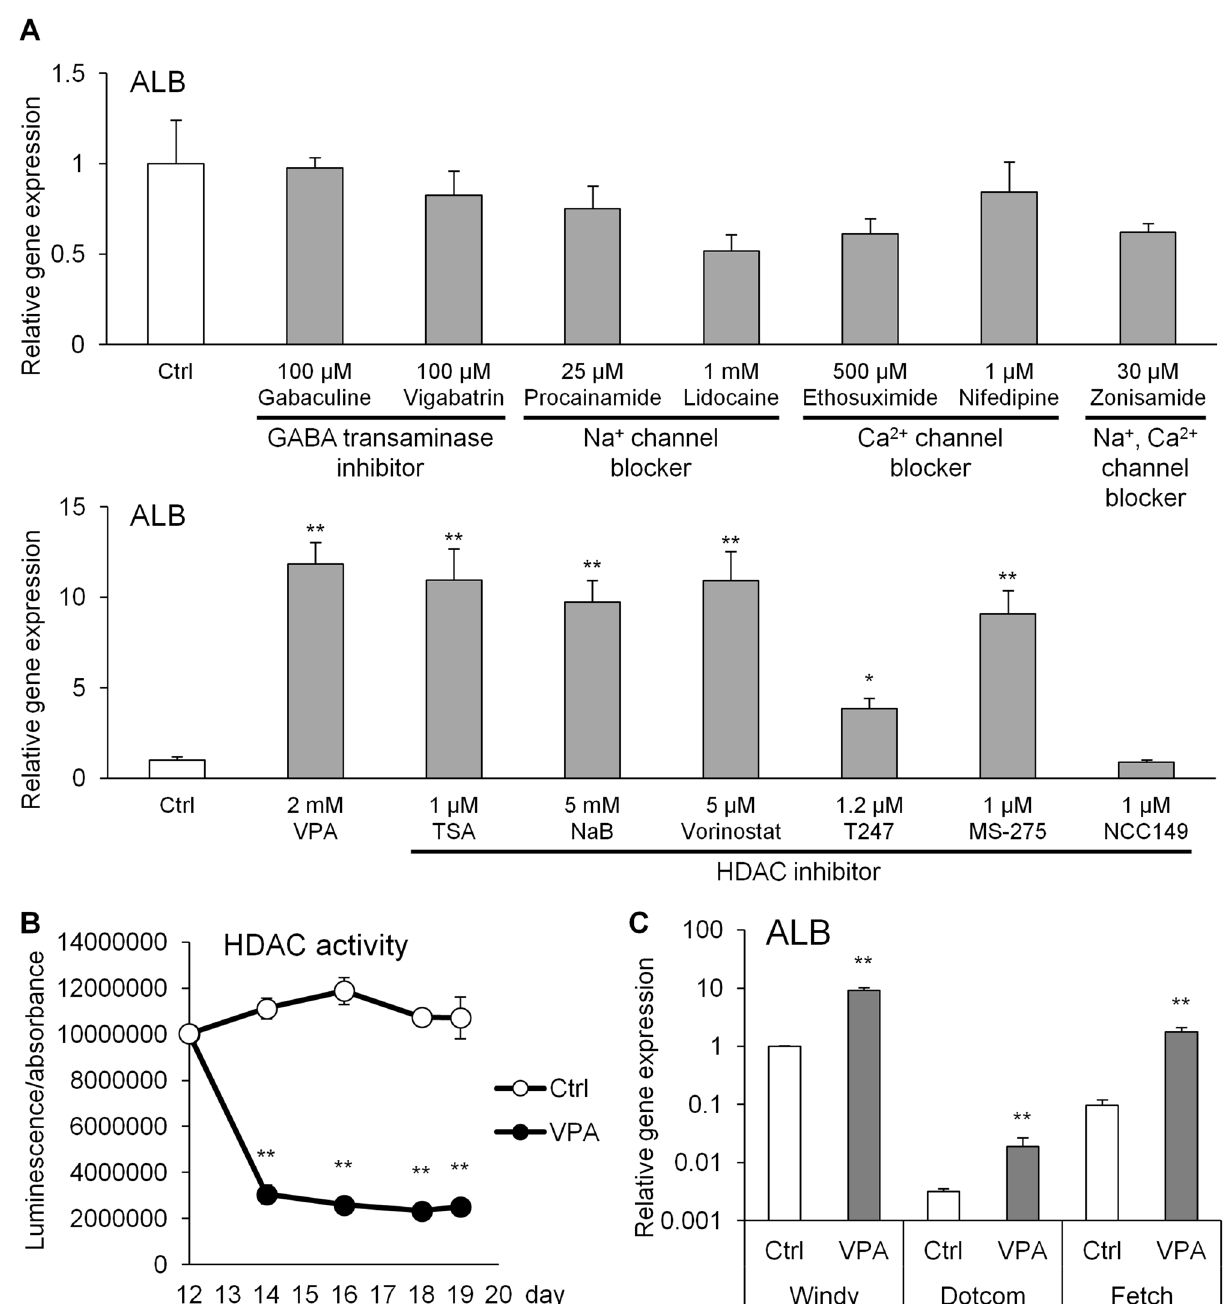
Figure 6. Effects of small-molecule compounds on hepatic differentiation from hiPS cells. All compounds were added to the medium for 168 h from day 12. (A) The albumin (ALB) mRNA expression level was analyzed in hepatocyte-like cells differentiated from hiPS cells (Windy). Each bar represents the mean 6 standard deviation ( n =3). The graph represents gene expression relative to that detected in compound-untreated hepatocyte-like cells [control (Ctrl)]. Levels of statistical significance compared with Ctrl: * P , 0.05 and ** P , 0.01. (B) Time-dependent changes in HDAC activity in differentiating human iPS (hiPS) cells (Windy). Symbols represent the mean 6 standard deviation ( n =4). Levels of statistical significance compared with Ctrl: ** P , 0.01. (C) The ALB mRNA expression level was analyzed in hepatocyte-like cells differentiated from three hiPS cell lines (Windy, Dotcom, and Fetch). Each bar represents the mean 6 standard deviation ( n =3). The graph represents gene expression relative to that detected in VPA-untreated hepatocyte-like cells differentiated from Windy. Levels of statistical significance in each cell line compared with each Ctrl, respectively: ** P , 0.01. The abbreviations used are: NaB, sodium butyrate; TSA, trichostatin A.